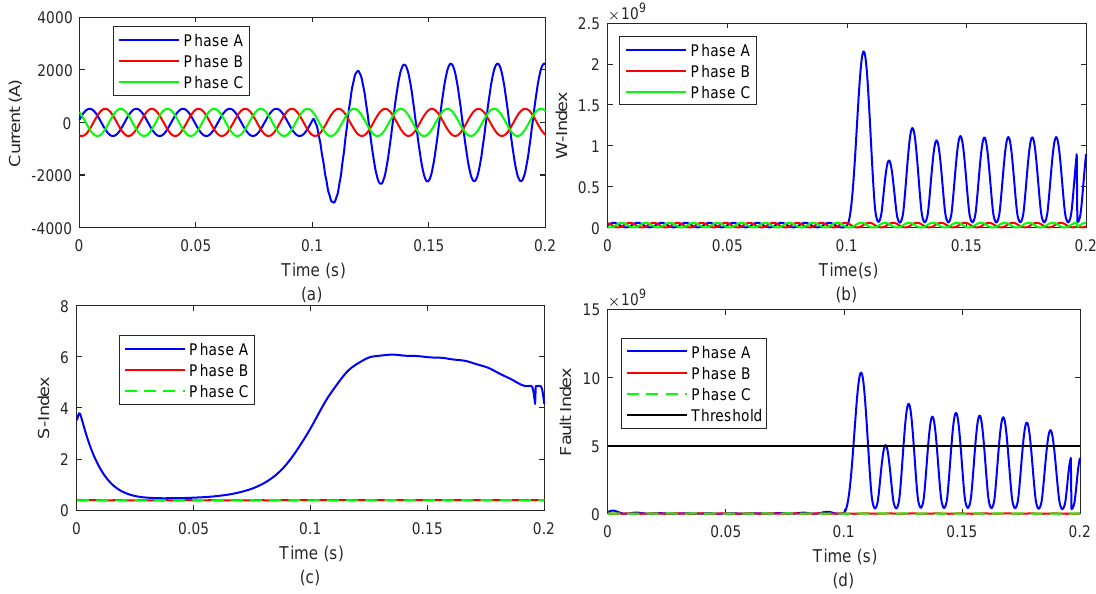
Figure 3. Identification of the fault with the L-G nature: ( a ) signals of the current ( b ) W-index ( c ) S-index and ( d ) FI.